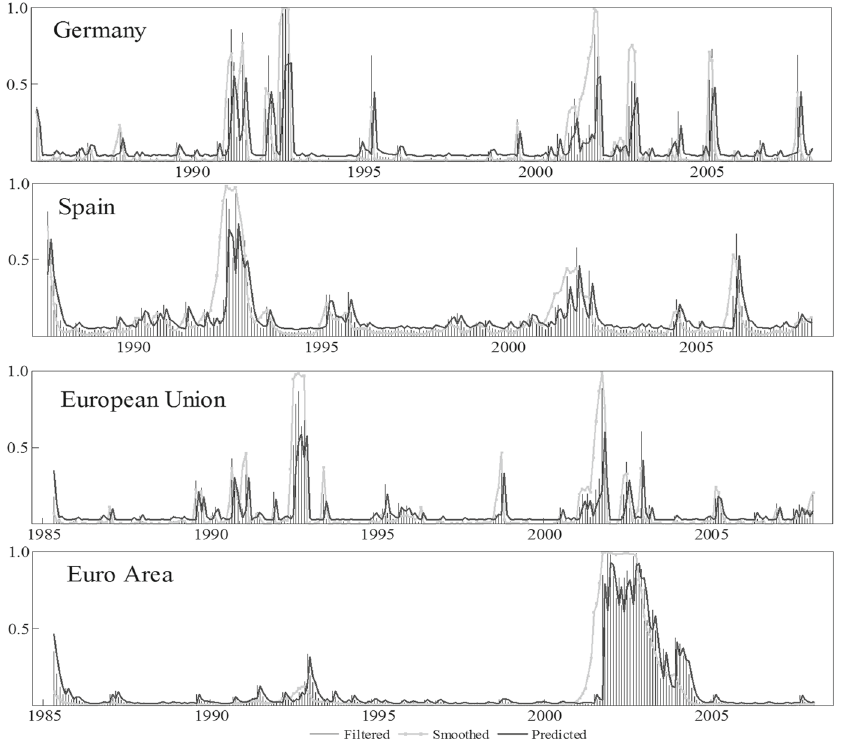
Fig. 3 Transition probability of the recession phase. Source: author’s calculations